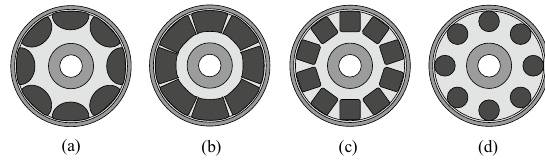
Figure 16 AFPMSM permanent-magnet shapes: a Semicircular, b Trapezoidal, c Rectangular, and d Circular